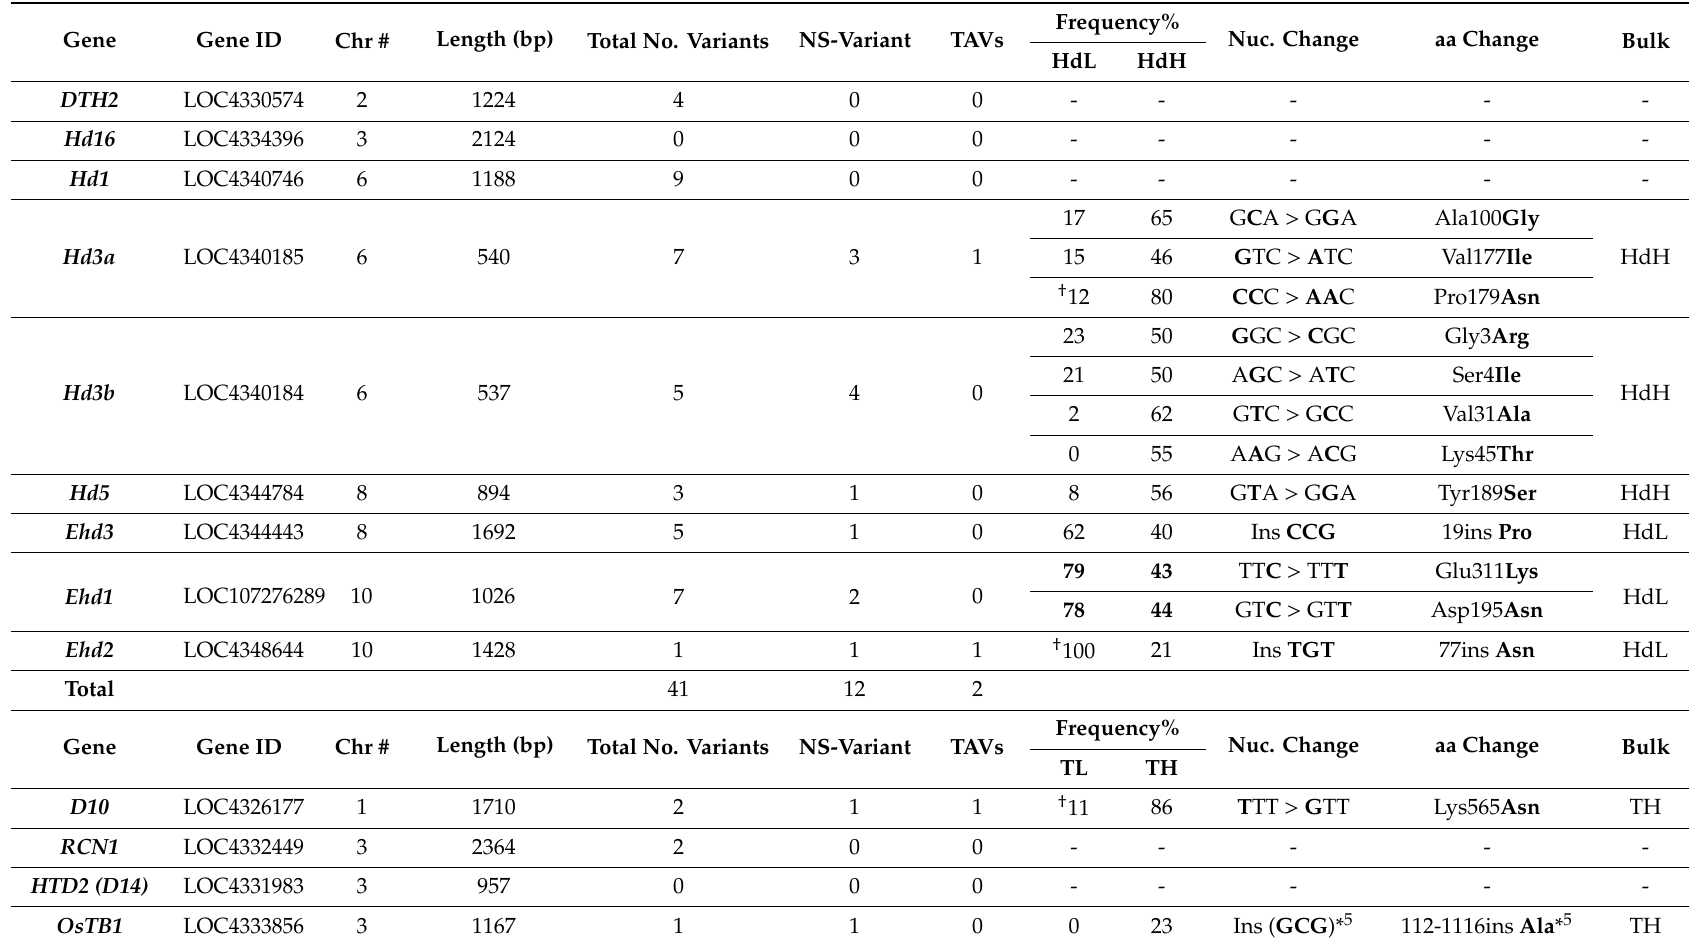
Table 2. Summary of the analysis of investigation of candidate genes for Hd, T, and TGW